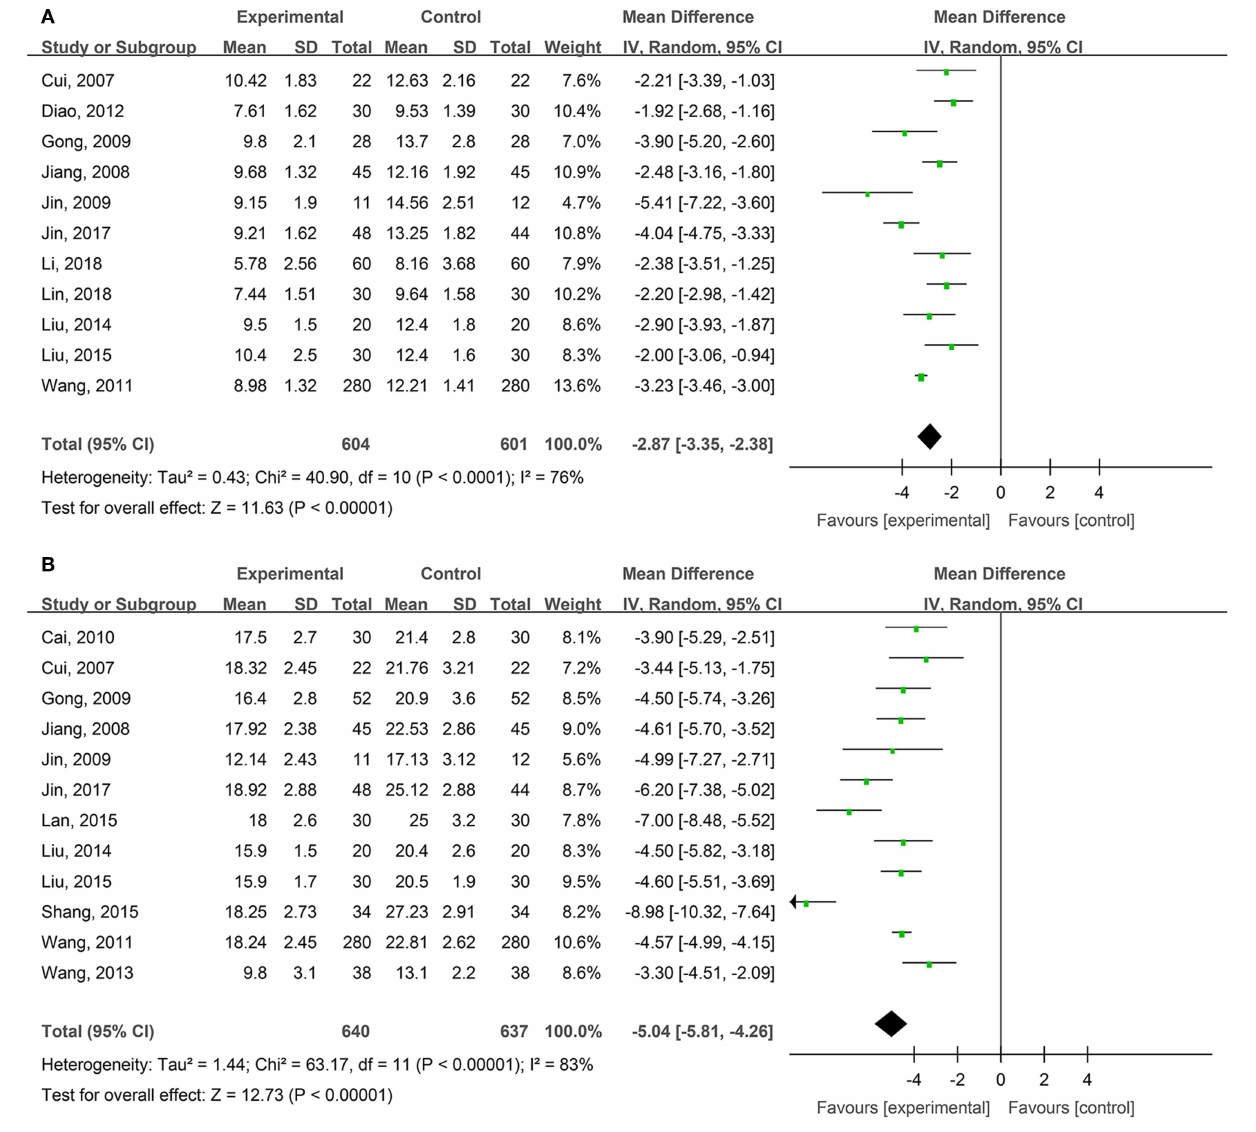
FIGURE 2 | Comparative meta-analysis of the healing times of degree-II superficial (A) and degree-II deep (B) burn